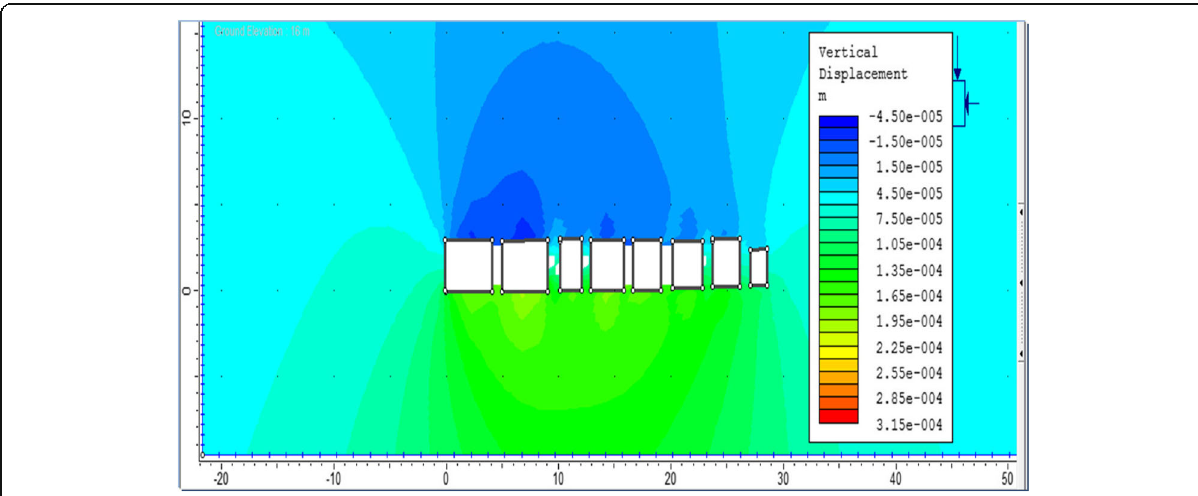
Fig. 15 Vertical displacement distribution through the rock pillars in Chamber 3. Examine 2D